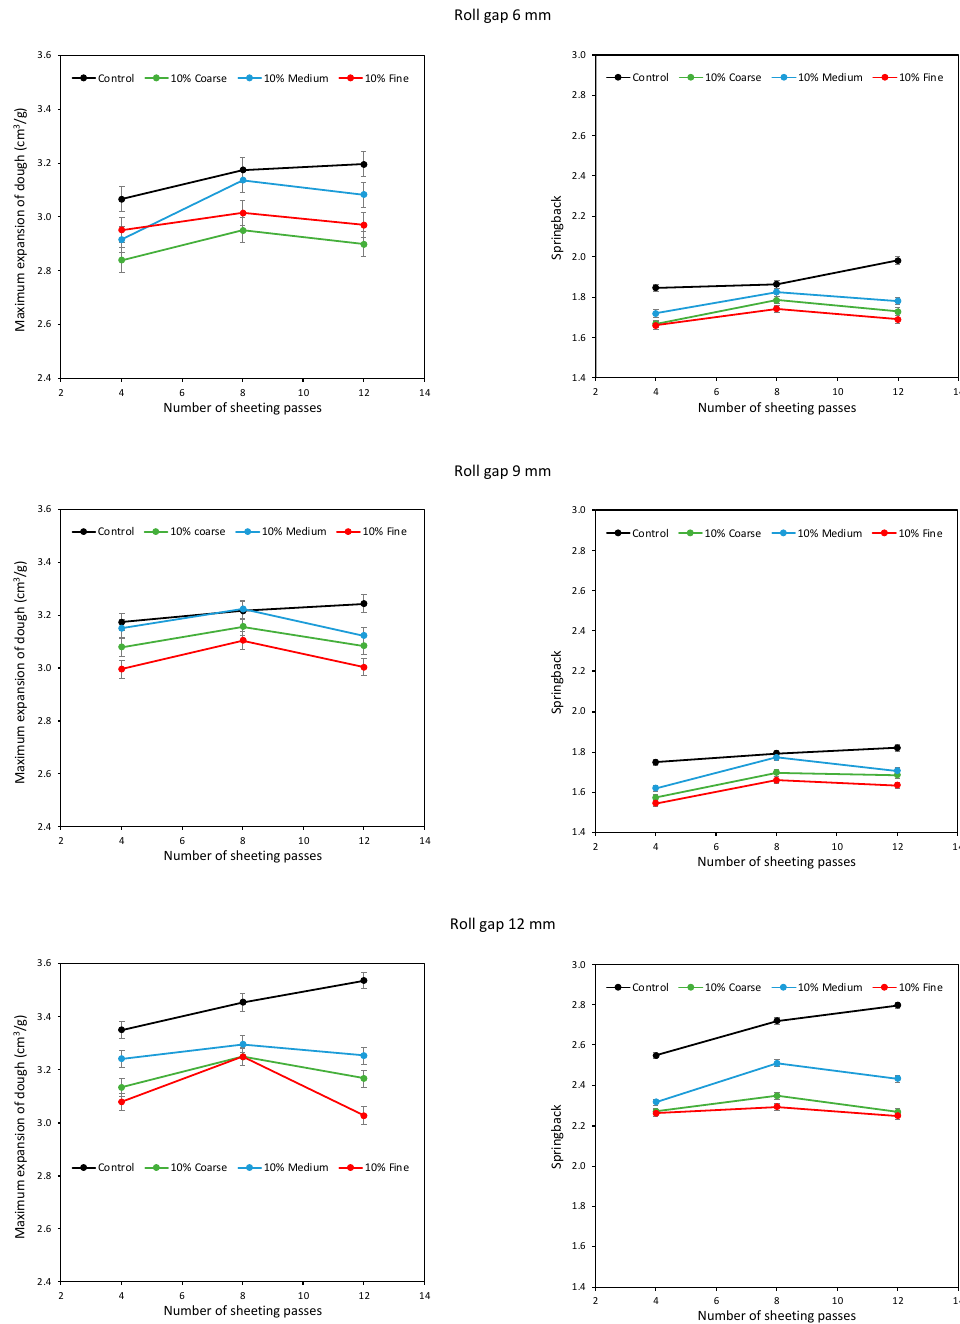
Figure 5. Average expansion ( left ) and springback ( right ) of doughs containing 10% Fine, Medium and Coarse bran, sheeted at roll gaps of 6 ( top ), 9 ( middle ) and 12 mm ( bottom ).